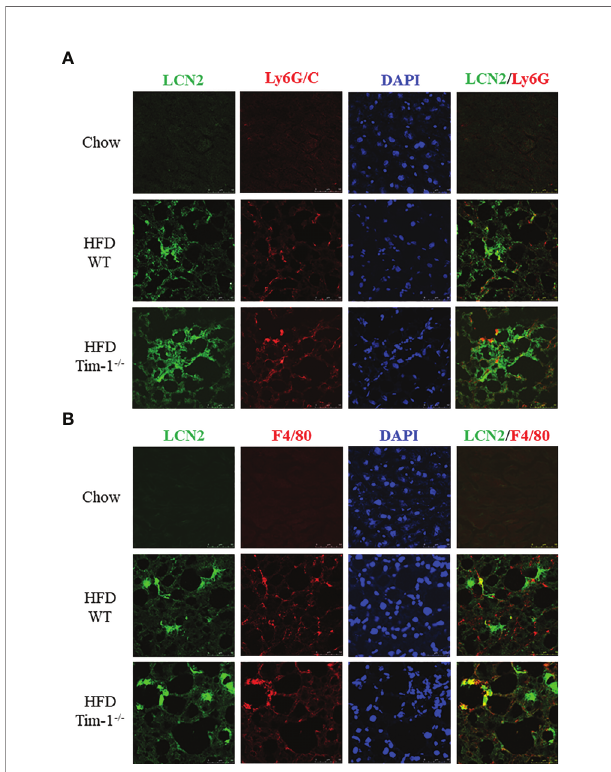
FIGURE 6 | Tim-1 de fi ciency increased LCN2 expression in in fi ltrated liver neutrophils and macrophages. Representative immuno fl uorescence images of double staining for LCN2 with neutrophil marker Ly6G/C (A) or macrophage marker F4/80 (B) in chow or HFD-fed WT and Tim-1 -/-